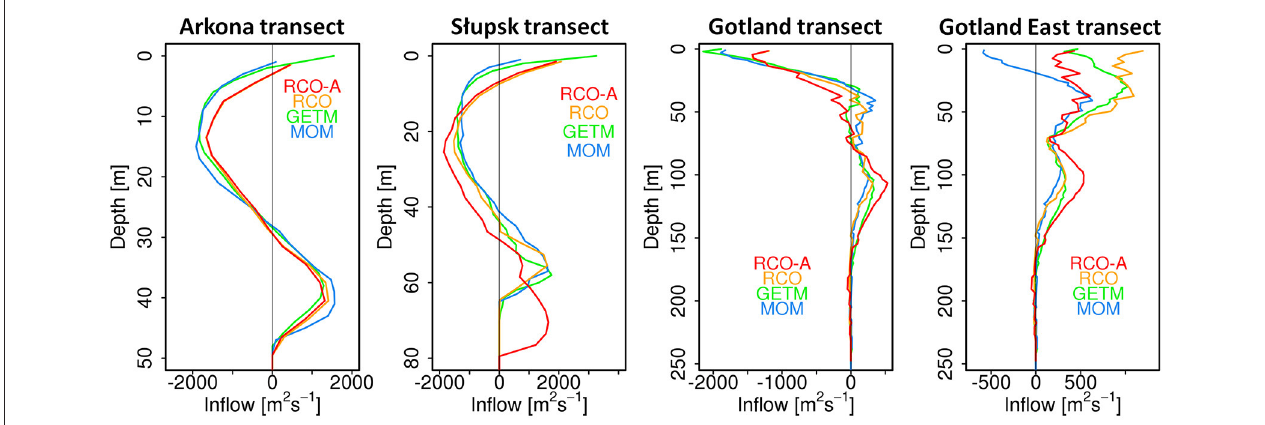
FIGURE 9 | Vertical profiles of horizontally integrated flows per unit depth along Arkona, Słupsk, and Gotland transect as well as along the eastern part of the Gotland transect only (between Gotland and Latvia) as simulated by the ocean models RCO-A (red), RCO (orange), GETM (green), and MOM (blue) for the time period from 1970 to 1999. Note the different depth ranges of the individual transects.